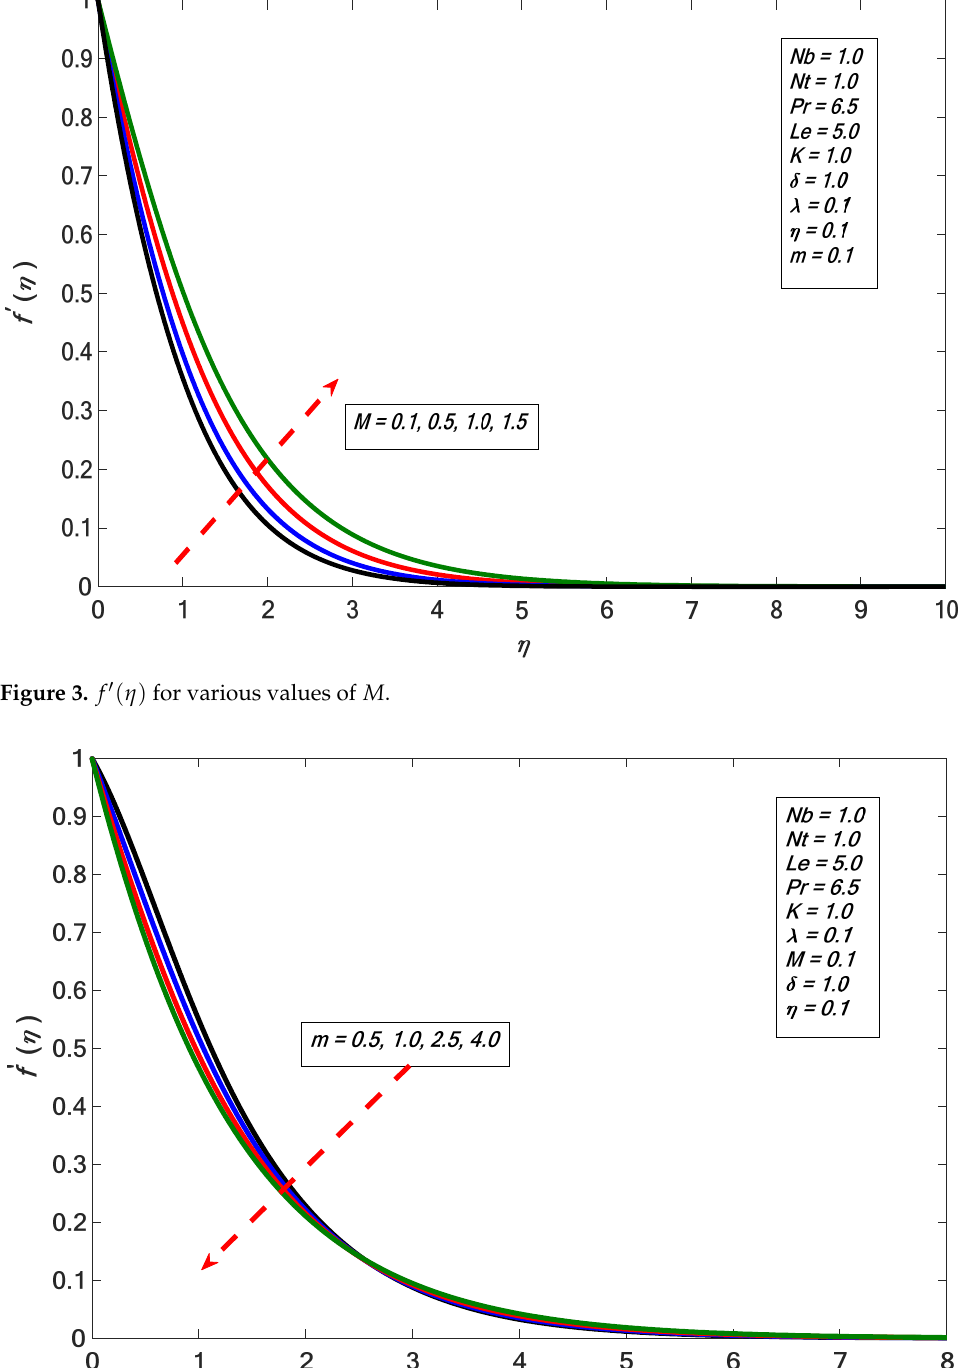
Figure 5. h (cid:4666)𝜂(cid:4667) for various values of 𝐾.